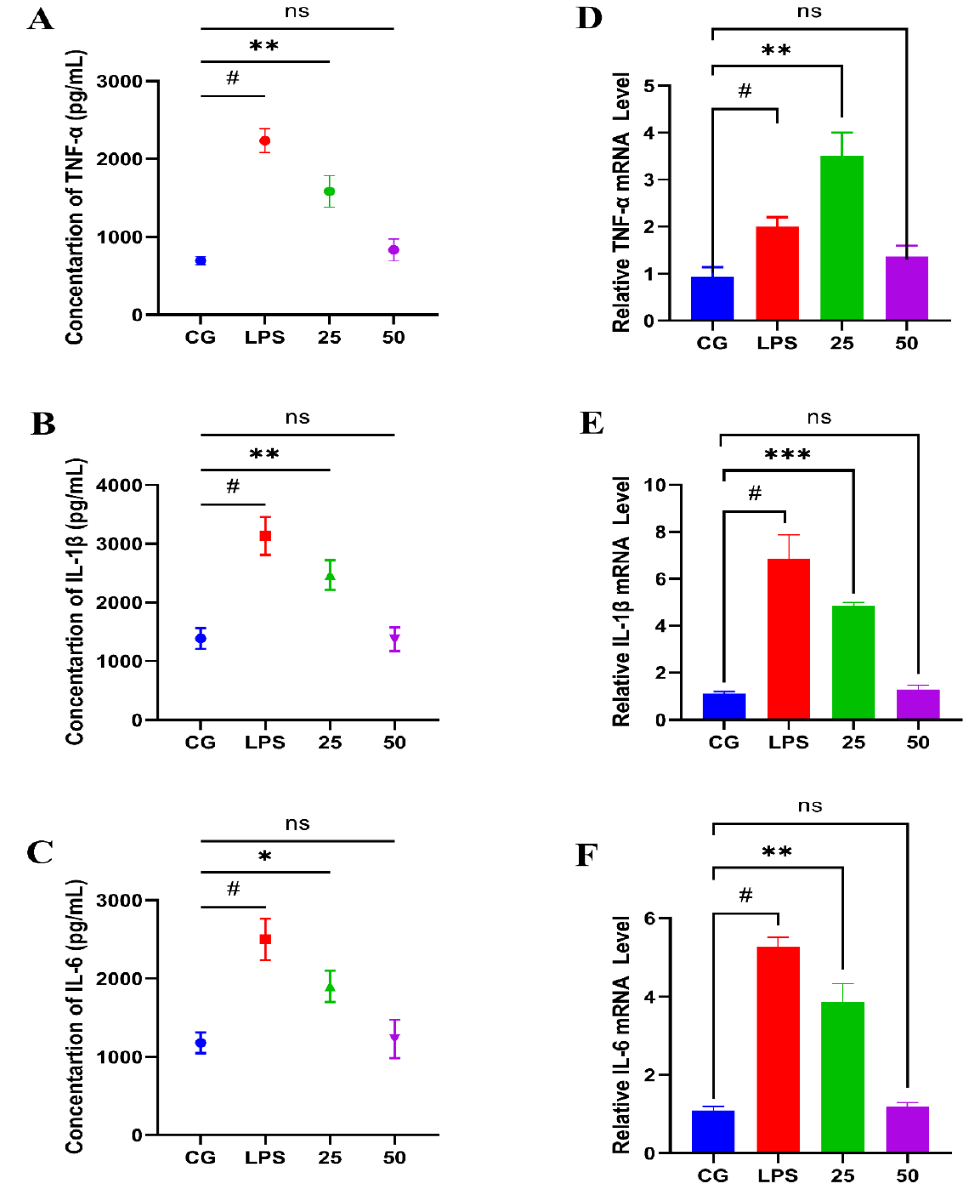
Figure 4. Effects of GnRb1 against LPS-induced production of pro-inflammatory cytokines. The concentration of: ( A ) the TNF- α (pg/mL); ( B ) the IL- 1β (pg/mL); and ( C ) IL-6 (pg/mL). The relative mRNA expression levels of ( D ) TNF- α, ( E ) IL- 1β; and ( F ) IL-6. CG represents the control group. LPS reveals the LPS-induced groups. The 25 and 50 are the GnRb1-administrated groups representing 25 mg/kg and 50 mg/kg per animal, respectively. GnRb1 indicates the Ginsenoside Rb1. Data statistics are demonstrated as mean ± S.E.M. The # p < 0.001 CG versus LPS group, * p < 0.05, ** p < 0.01, *** p < 0.001, and ns indicates the nonsignificant difference between CG versus LPS + GnRb1 groups.